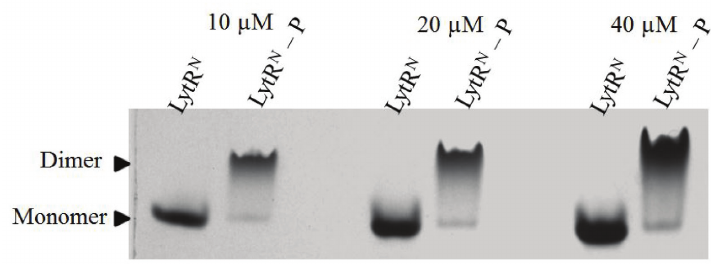
Figure 5. The effect of phosphorylation on the oligomerization states of LytR N . LytR N and LytR N –P at 10 µM, 20 µM and 40 µM were analyzed by 15% native-PAGE and stained with Coomassie